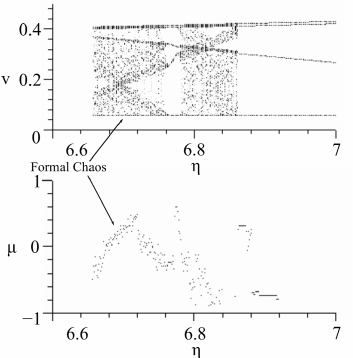
Figure 14. Bifurcation diagram with η